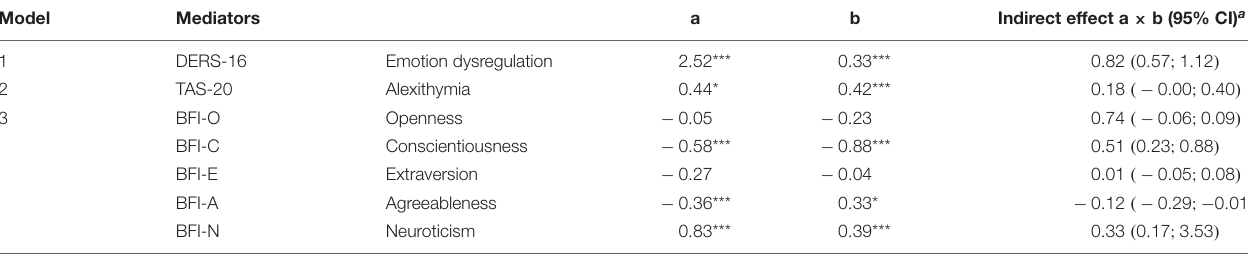
TABLE 4 | Mediation of the effects of probable adult ADHD on significant BE.